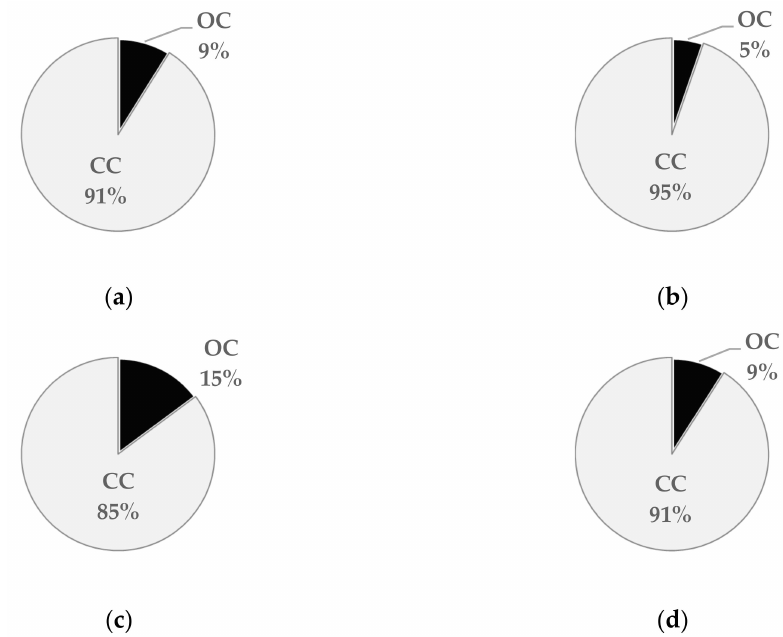
Figure 3. Distribution of the operational costs (OC) and capital costs (CC) for a laboratory ( a , b ) and an industrial ( c , d ) freeze-dryer. The capital costs were calculated in this work considering a 7-day working week ( a , c ) in which there are no interruptions in the production and a 5-day working week ( b , d ) that accounts for plant stops during the